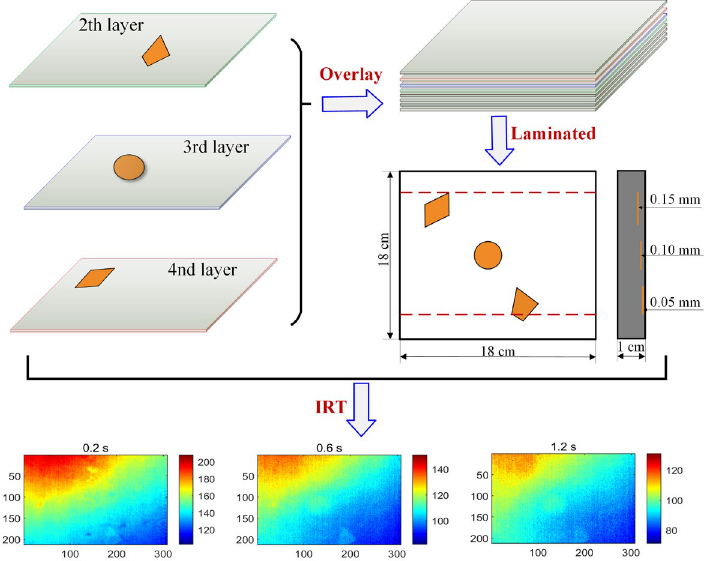
Figure 5. Fabrication of CFRP specimen with defects and several frames of raw thermal images.